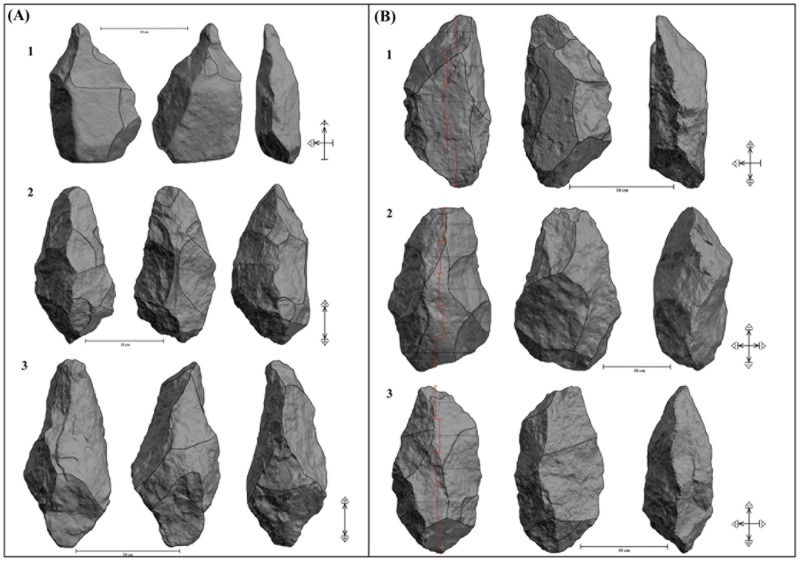
LCTs from FLK W.(A) 3D Models of 3 trihedrals and their tool functioning schemes. (B) 3D models of 3 handaxes and their tool functioning schemes (note their lack of frontal symmetry).